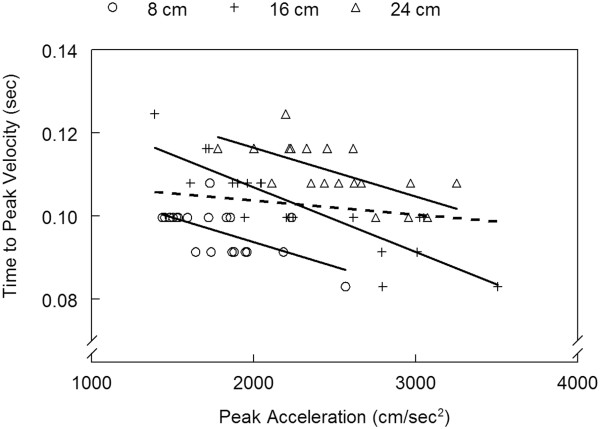
Relationship between time to peak velocity and peak acceleration by target distance. Data is from the same participant shown in Figure 3 reaching to the +45° targets in the virtual environment. Data points represent individual reach trials to each target (circle = 8 cm target; cross = 16 cm target; triangle = 24 cm target). Solid lines are the linear regression lines fit to the data for each target (correlation coefficients: r = -0.616 for 8 cm target; r = -0.856 for 16 cm target; r = -0.680 for 24 cm target; all significant at p < 0.01). Dotted line is the linear regression line fit to all data points combined across targets (r = -0.179, p = .172).